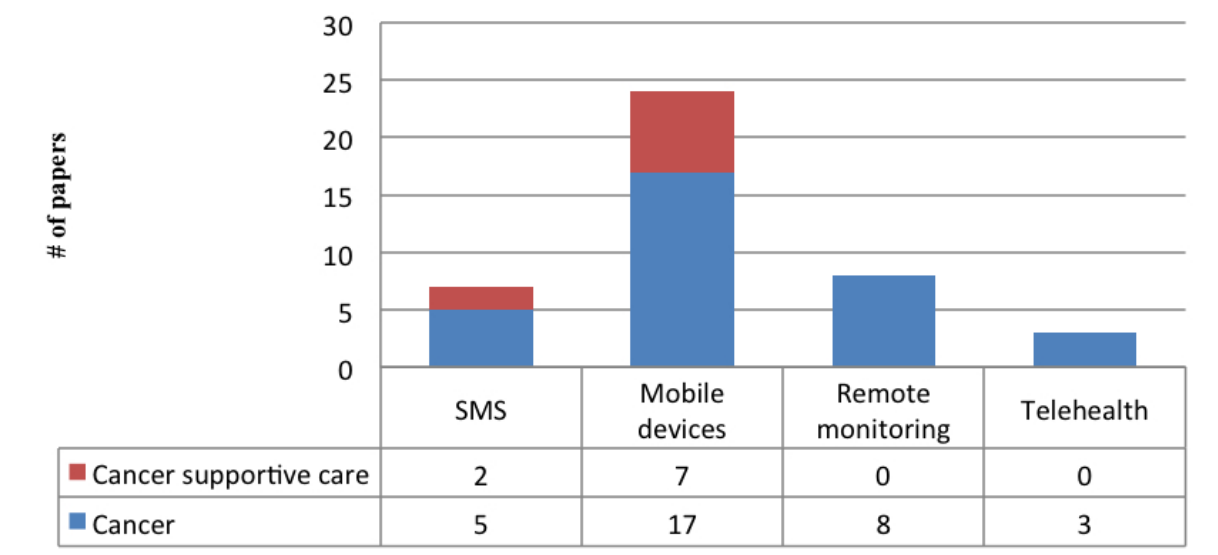
Figure 10. Mobile technologies and diseases.